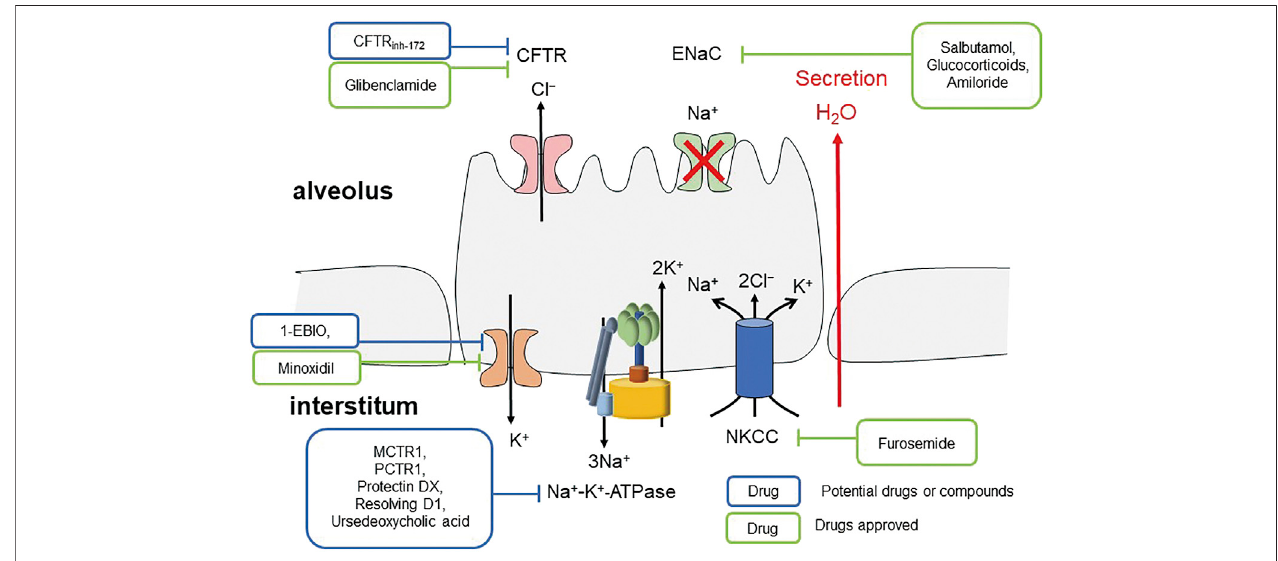
FIGURE 4 | Mechanism of inhibiting ENaC inducing pulmonary